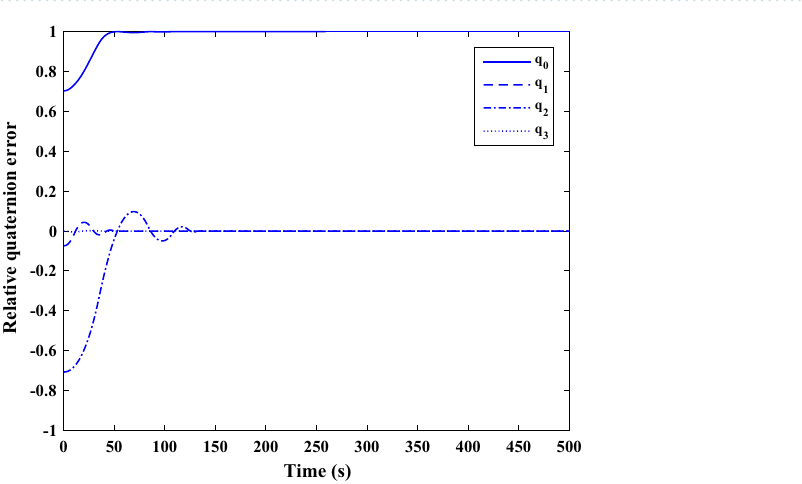
Figure 35. Scenario II: quaternion parameters tracking.